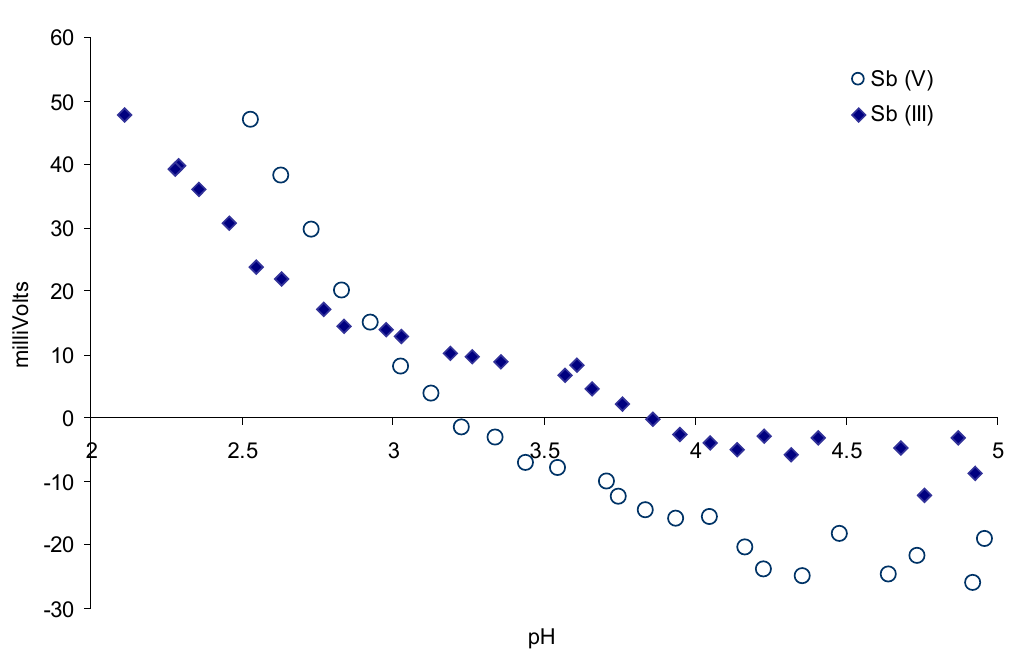
Figure 2. Point of zero charge (pzc) curves of ( ○ ) Sb(V) doped and ( ♦ )Sb(III) doped tin dioxide in 0.001 M NaCl solution. The pzc of pure tin dioxide was at pH 5.3